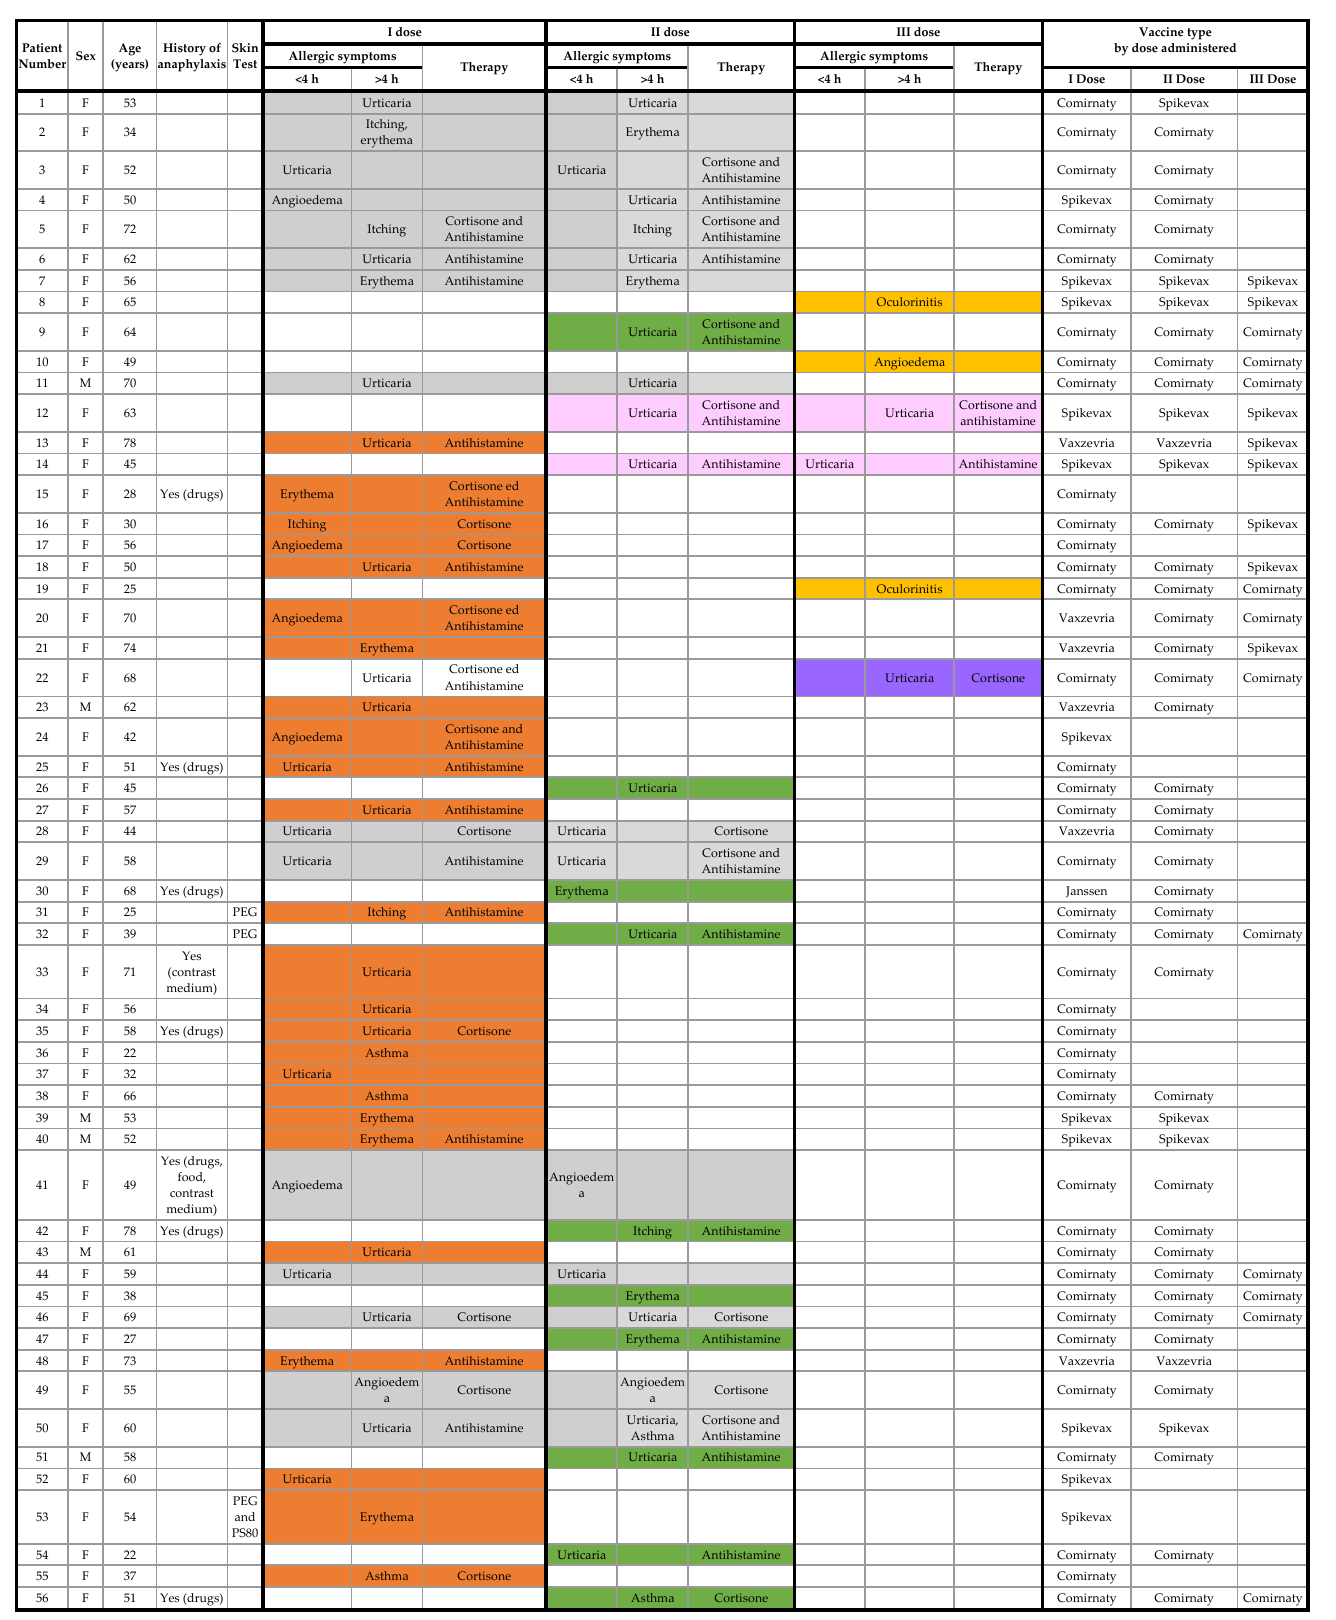
Table 3. Allergic reactions to COVID-19 vaccination, reported by high-risk allergic patients of ASUGI Trieste. M = males; F =